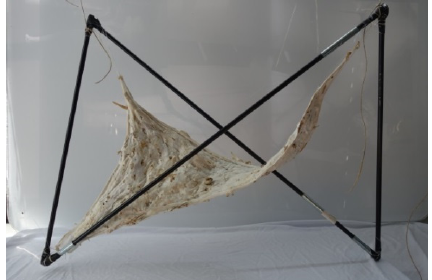
Figure 17. Triangular textile/mycelium shell.